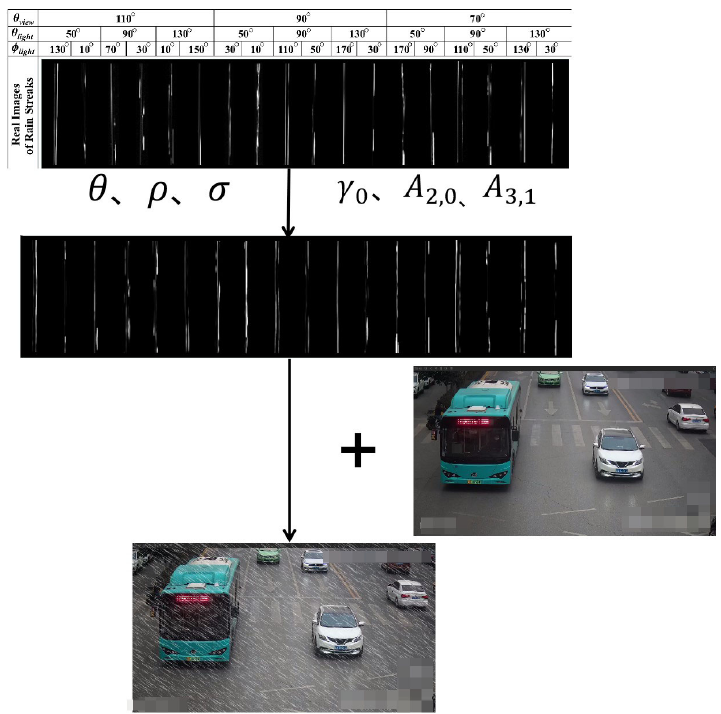
Figure 1. Synthesis process of rain image using photoshop software